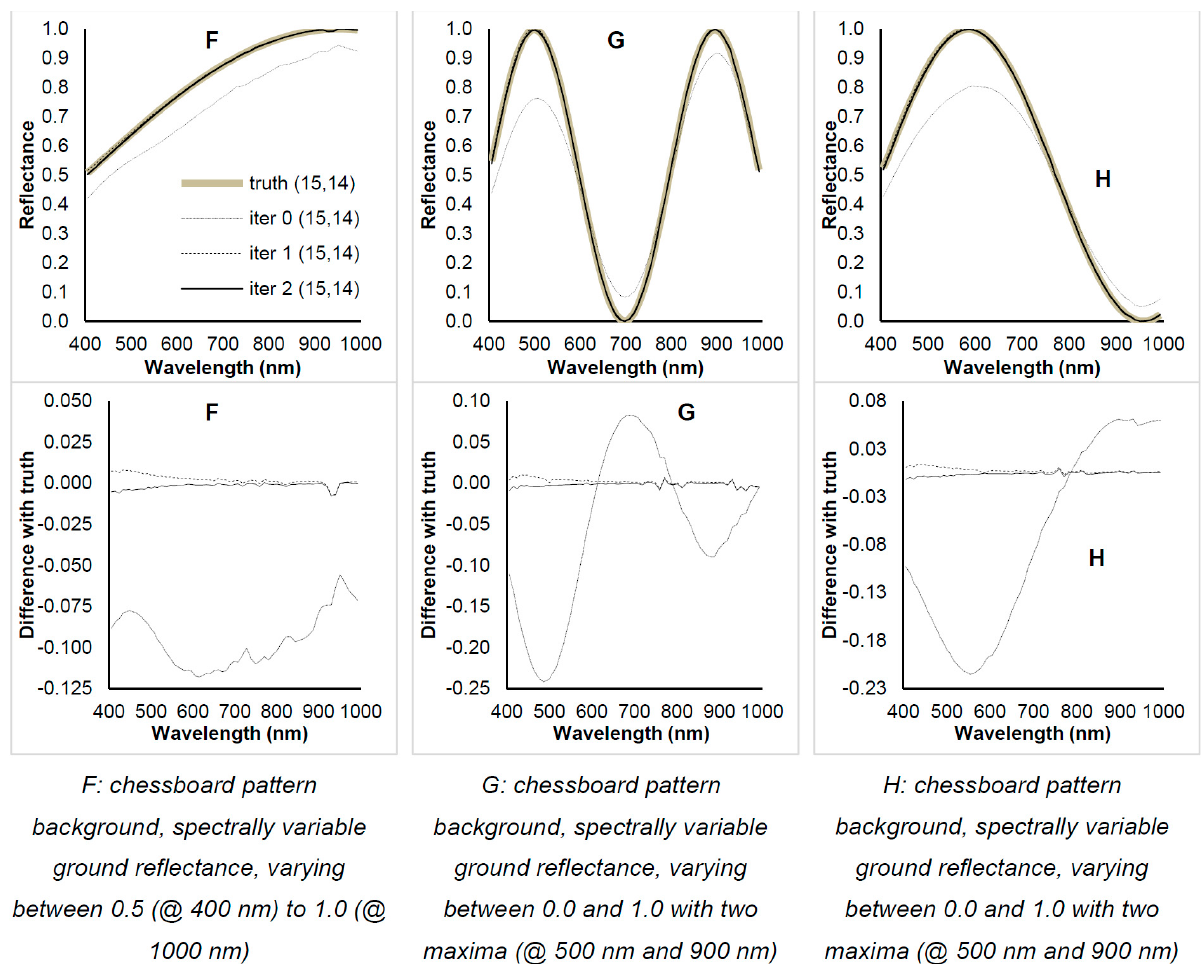
Figure 6. Reflectance spectra of the pixels F, G and H as the number of iterations increases. The pattern of surrounding pixels affects the first retrieval (iteration 0). The retrieved reflectance converges to the real value after the subsequent iterations. Both the reflectance spectra (at the top ) and their difference with the ground truth (at the bottom ) are shown.